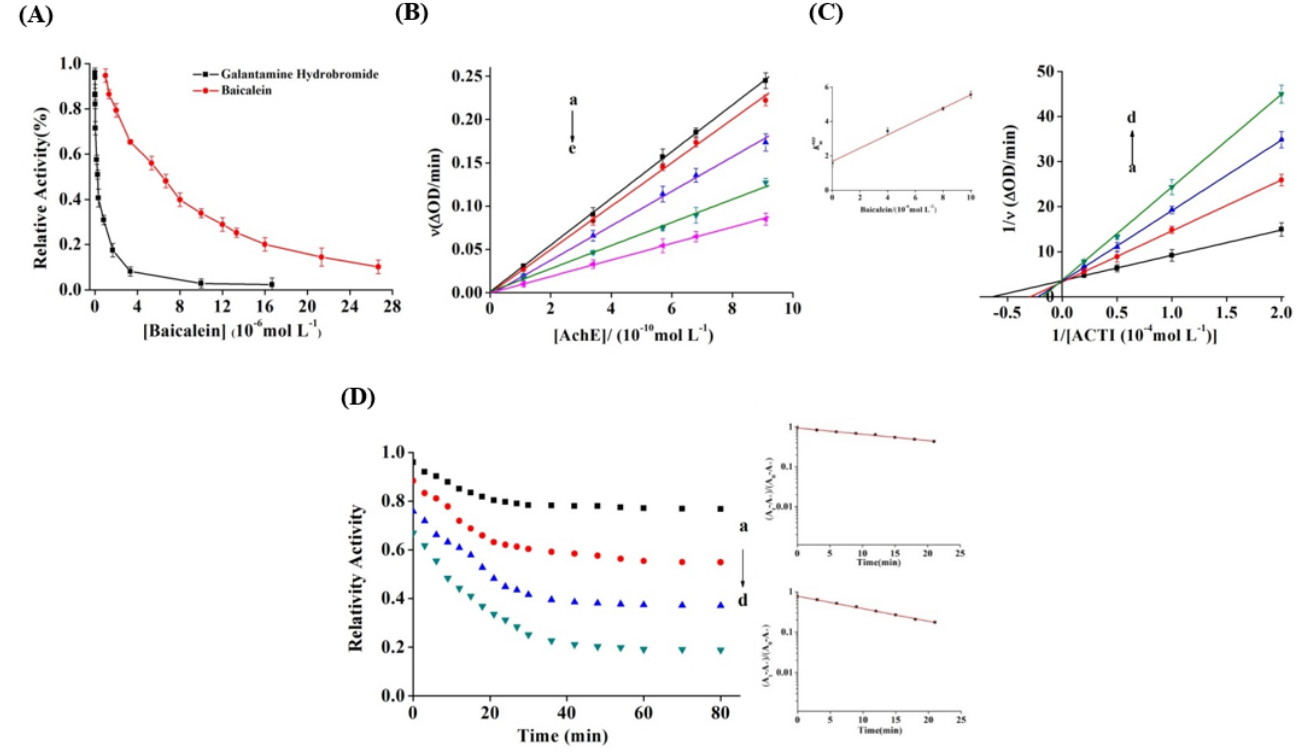
Figure 2. ( A ) Effect of baicalein and galantamine hydrobromide on the activity of AChE at 25 °C (pH 7.6); c (AChE) = 0.57 nM, c (ACTI) = 0.25 mM. ( B ) Plots of v versus (AChE). c( ACTI) = 0.25 mM and c (baicalein) = 0, 2, 4, 8, and 16 µM for curves a → e, respectively. ( C ) Lineweaver–Burk curve of baicalein, c (AChE) = 0.57 nM; c (baicalein) = 0, 4, 8, and 10 µM for curves a → d. ( D ) Time course for the relative activity of AChE in the presence of baicalein at the concentrations of 2, 4, 8, and 16 µM for curves a → d, respectively. c (AChE) = 0.57 nM and c (ACTI) = 0.25 mM. Semilogarithmic plot analysis for baicalein at 2 µM (the upper-right panel) and 16 µM (the lower- right panel), and the slope of the curves suggests the inactivation rate